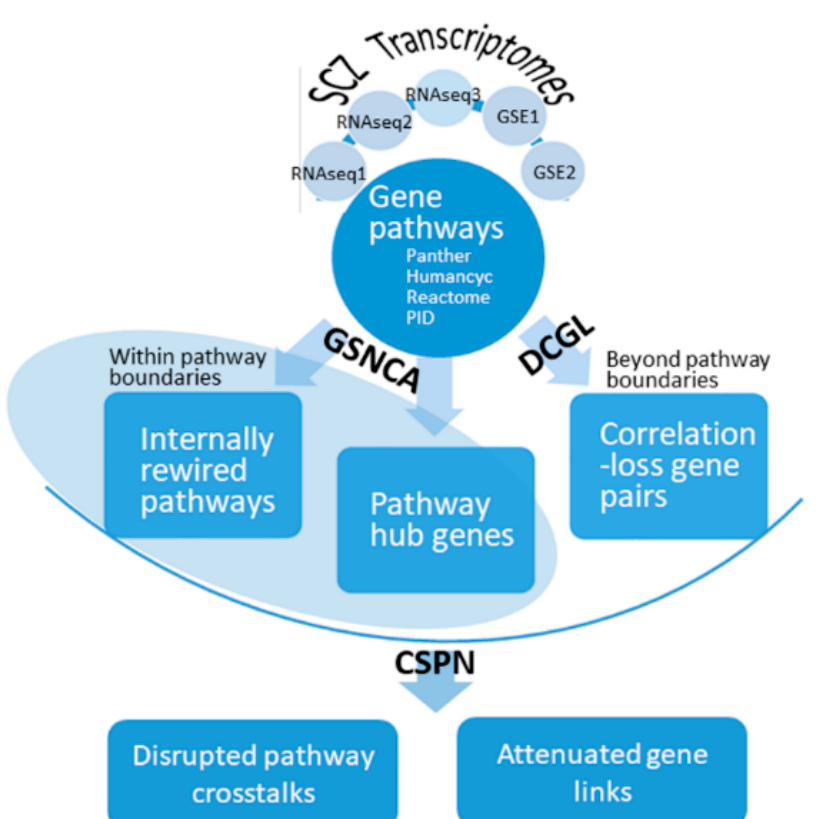
Figure 1. Workflow to identify rewired pathways, disrupted pathway crosstalk circuits, and critical genes and gene links in schizophrenia. A gene expression matrix originating from RNA-Seq or microarray contained expression profiles for tens of thousands of genes across two contrasted pheno- types: control (normal) and schizophrenia (SCZ). Such an expression matrix was analyzed by